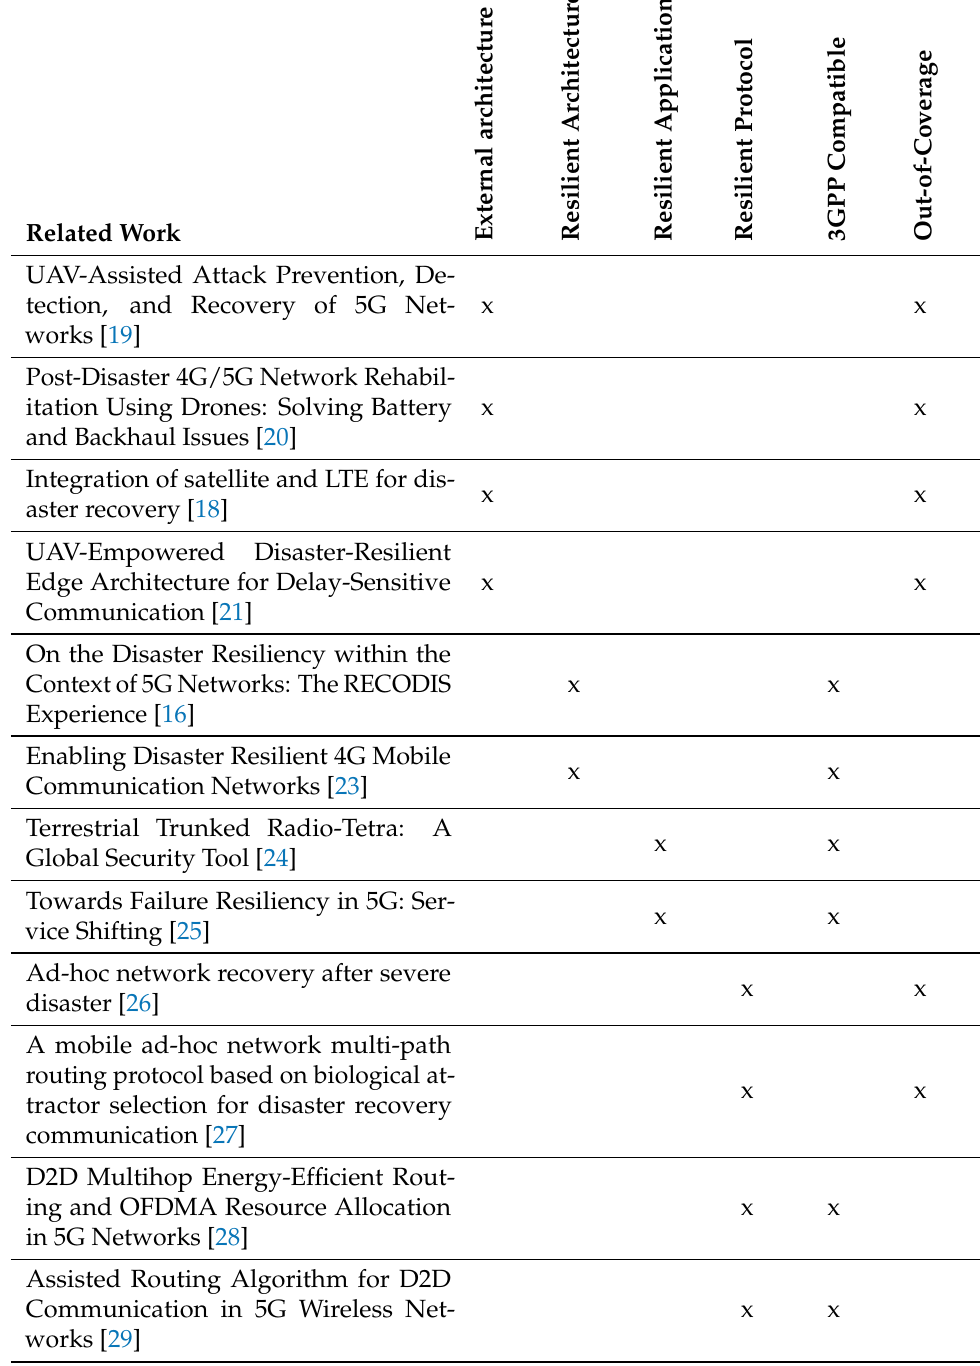
Table 1. Existing works in the literature on wireless network